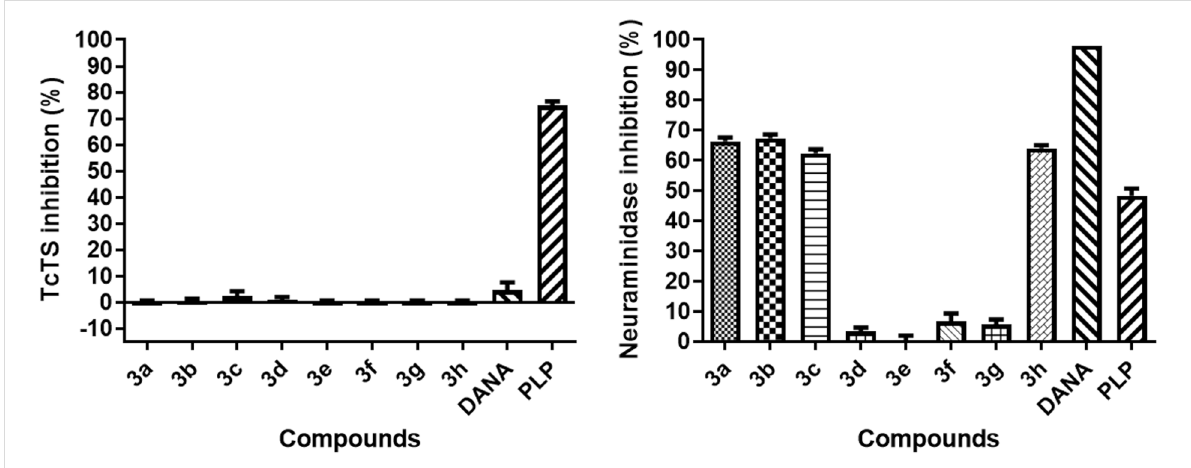
Figure 4: TcTS and neuraminidase inhibition by 1,2,3-triazole-linked sialic acid derivatives 3a–h (1 mM) using a fluorimetric assay. DANA (2,3- dehydro-2-deoxy- N -acetylneuraminic acid) and PLP (pyridoxal phosphate) were used as positive controls at 1 mM.